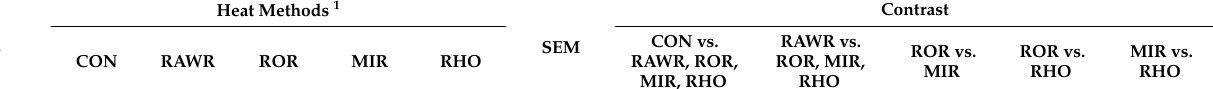
Table 6. Effect of different heated rubber seed kernel on fatty acid profile in the